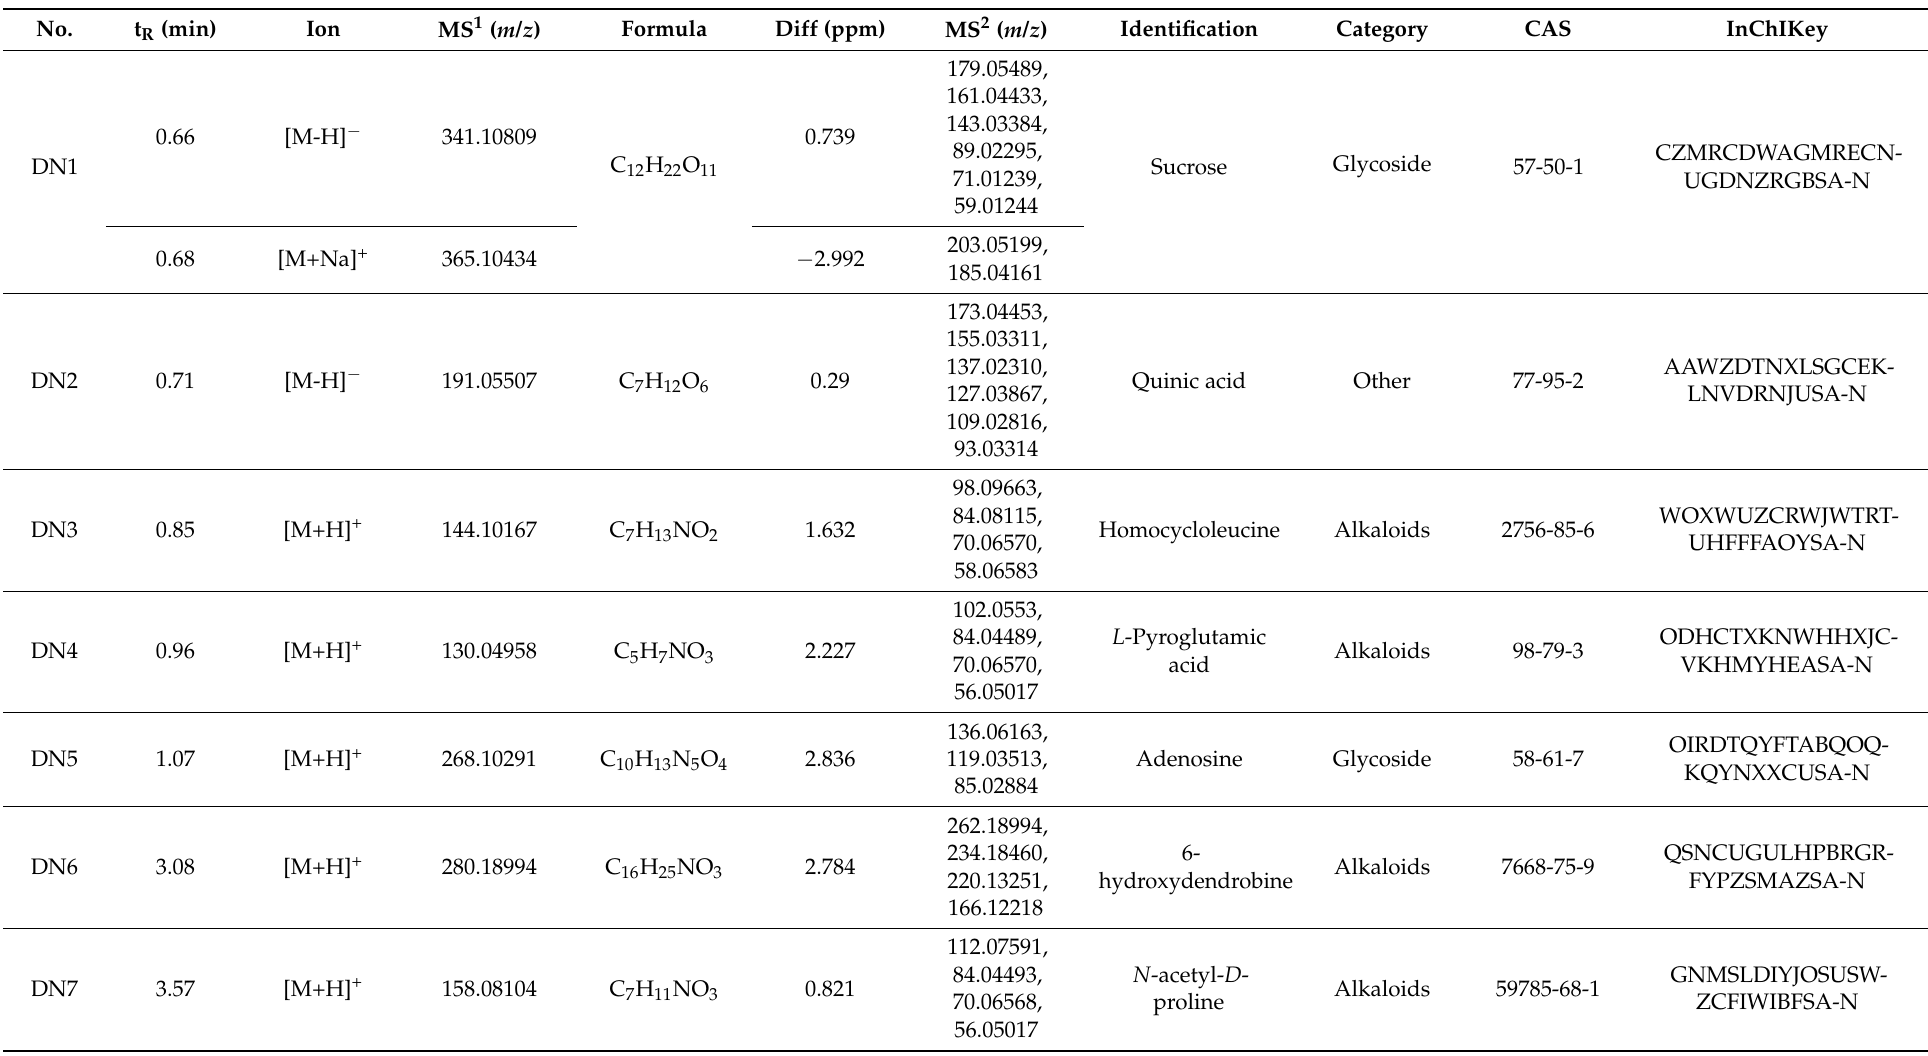
Table 1. Identified chemical constituents in D. nobile by